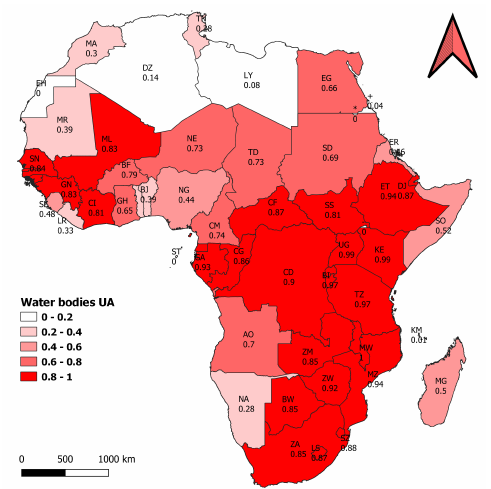
Figure 5. PA for Forest per country